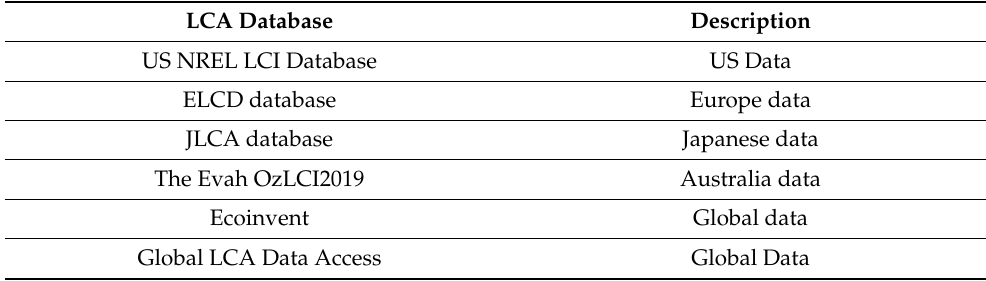
Table 1. LCA databases [18].